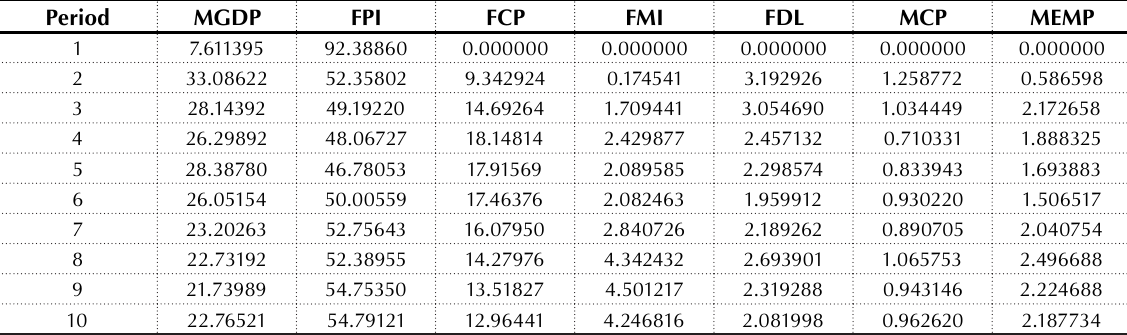
Table A5 . Variance decomposition of